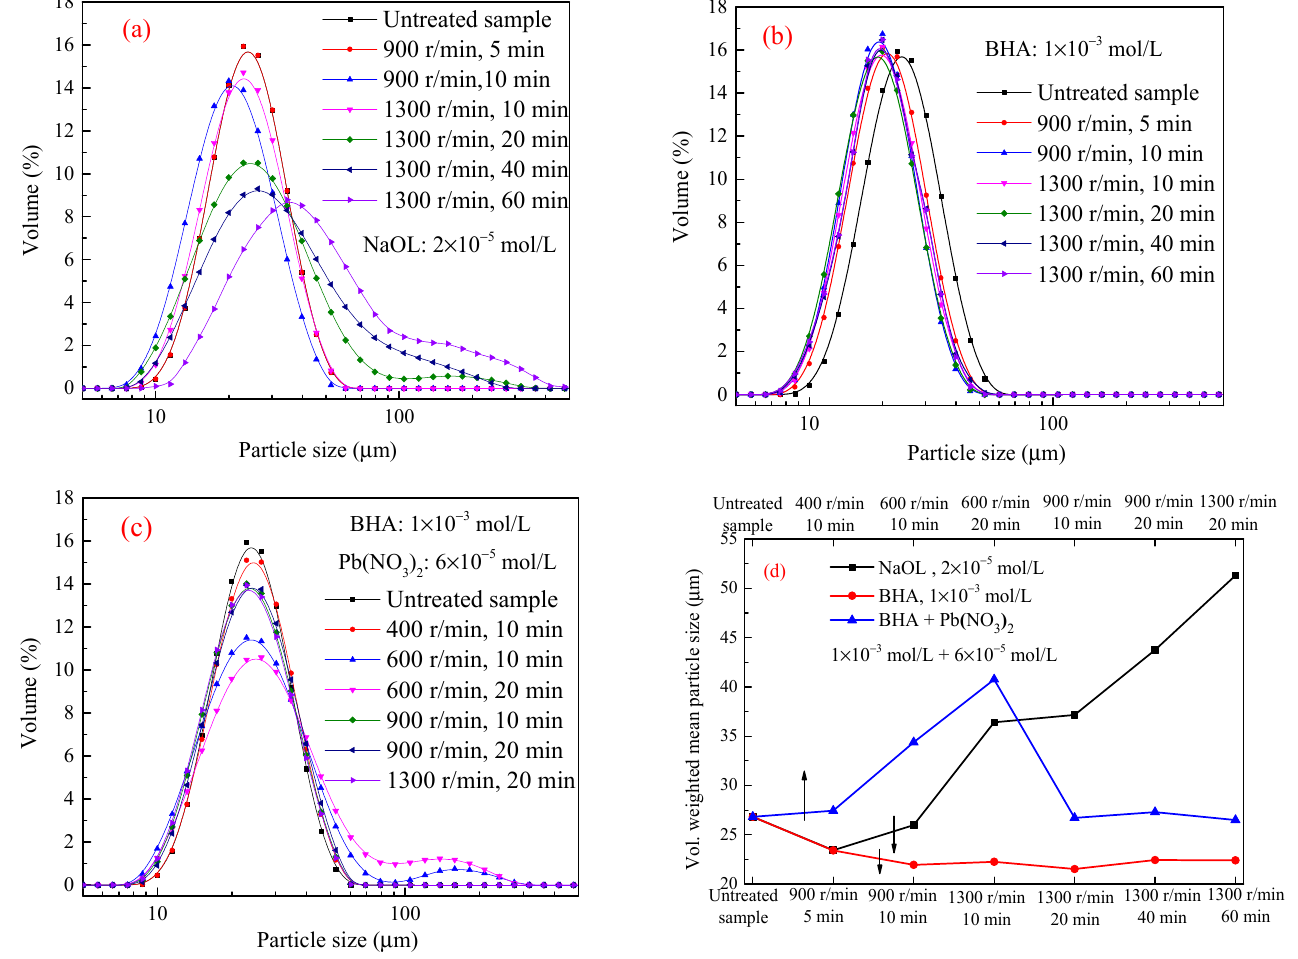
Figure 6. The particle size analysis results of − 37 + 10 μ m cassiterite in the presence of NaOL ( a ), BHA ( b ), and BHA + Pb 2+ ( c ) under different stirring conditions, ( d ): vol. weighted mean particle size (pH = 8.5–9).